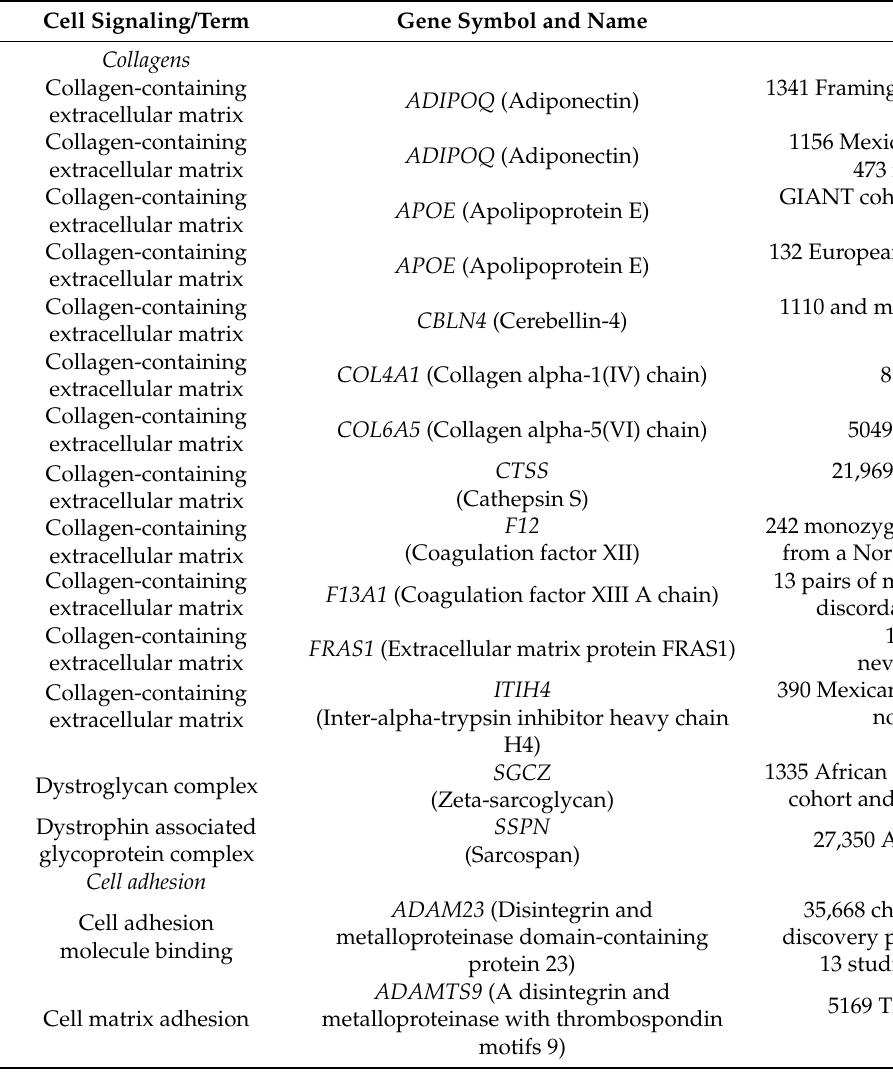
Table 1. Whole-genome genetics approaches reveal the implication of extracellular matrix (ECM) in obesity and metabolic